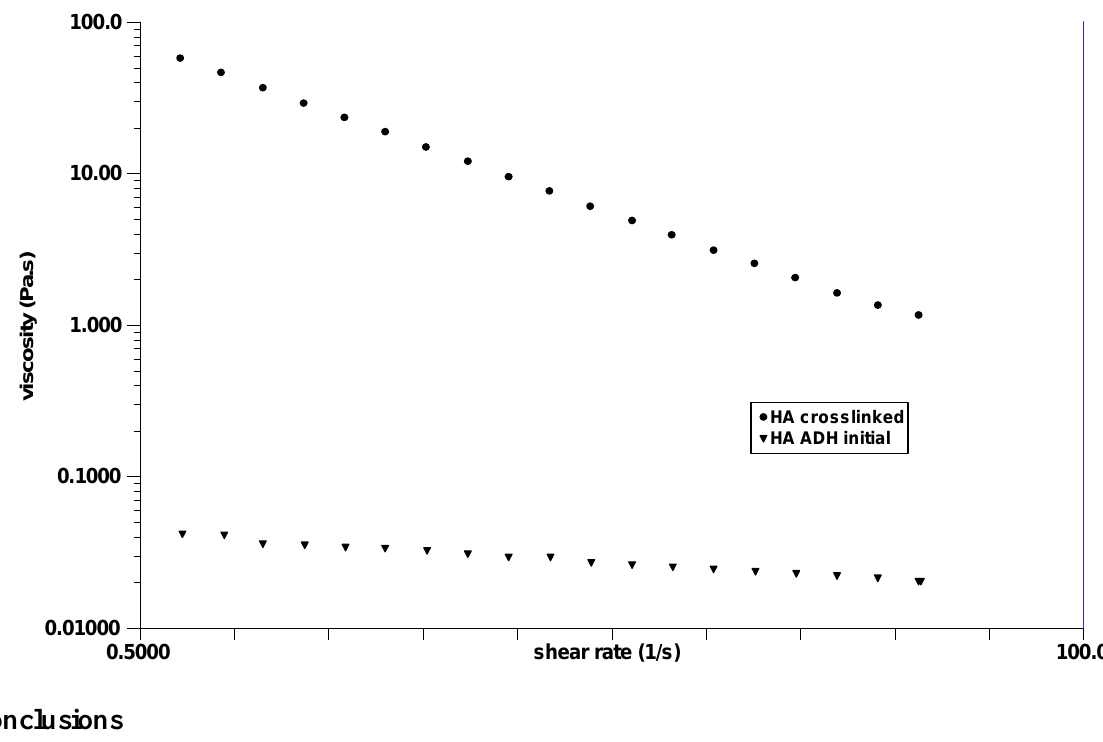
Figure 11. Influence of the crosslinkage on the viscosity measured as a function of the shear rate on HA –ME 50 copolymer. Solvent: water; temperature: 25